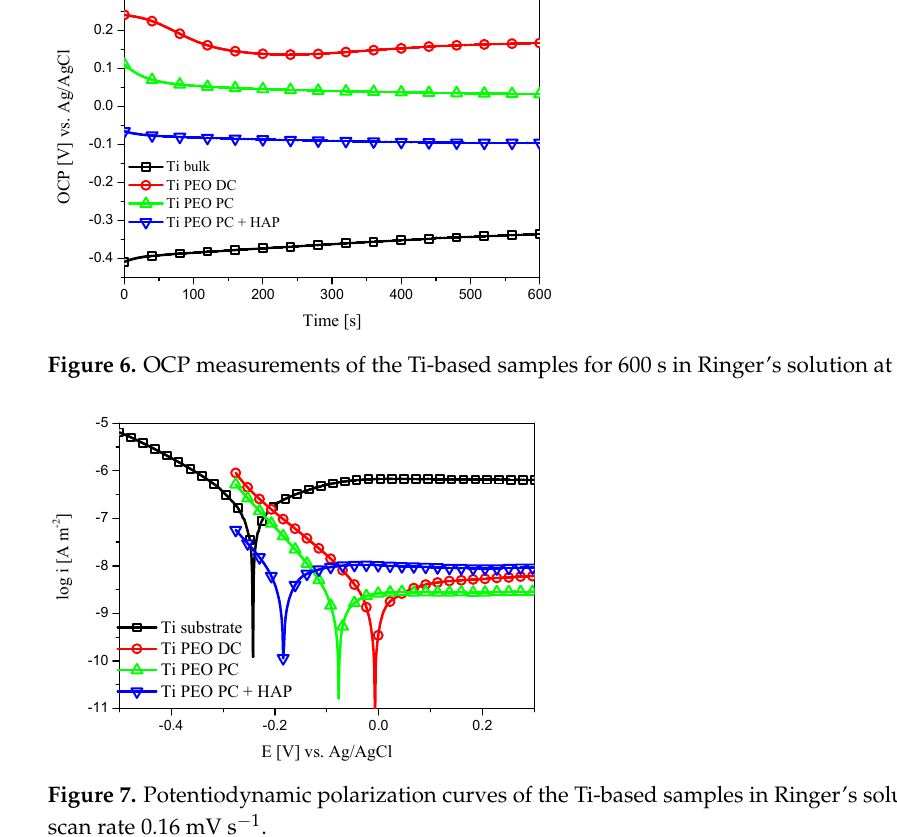
Figure 7. Potentiodynamic polarization curves of the Ti-based samples in Ringer’s solution at 37 °C, scan rate 0.16 mV s −1 . Table 2. Corrosion parameters were estimated from the Tafel extrapolation method.